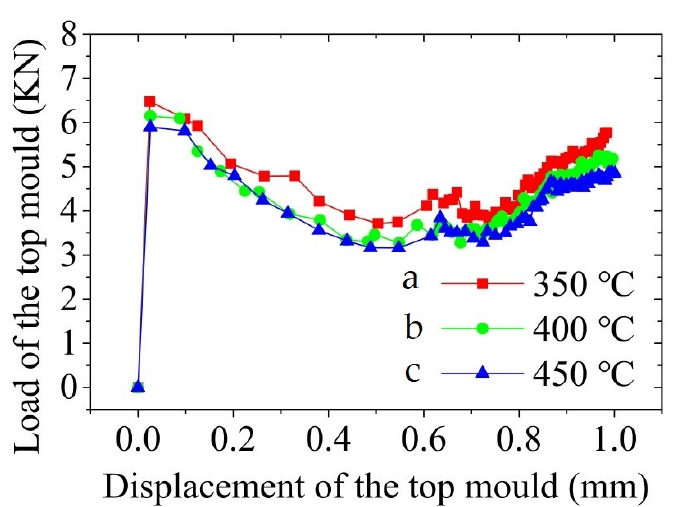
Figure 10. Load-displacement curve of the top mould during the thixotropic extrusion at the mould temperature of ( a ) 350 °C, ( b ) 400 °C, and ( c ) 450 °C.